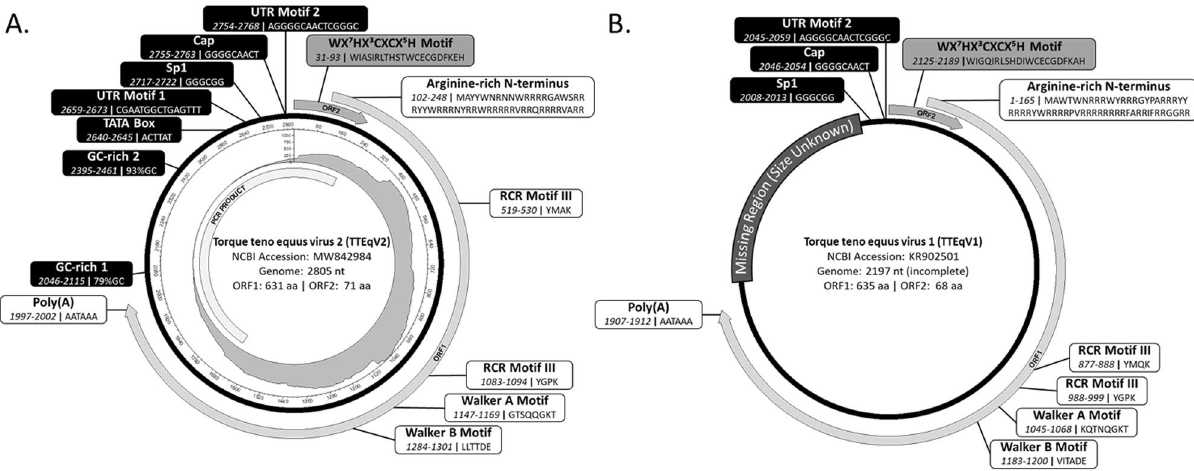
Figure 3. Genomic structure of ( A ) Torque teno equus virus 2 (TTEqV2) and ( B ) Torque teno equus virus 1 (TTEqV1). Inside the annotated circular genome for TTEqV2 is a plot showing the coverage at each nucleotide position (generated using circlize v0.4.15 58 ). The region sequenced via subsequent targeted amplicon sequencing is indicated by a bar within the coverage plot. For both viruses, genomic features of interest are labelled with the feature name followed by the position and sequence (or GC content for GC-rich regions in TTEqV2)